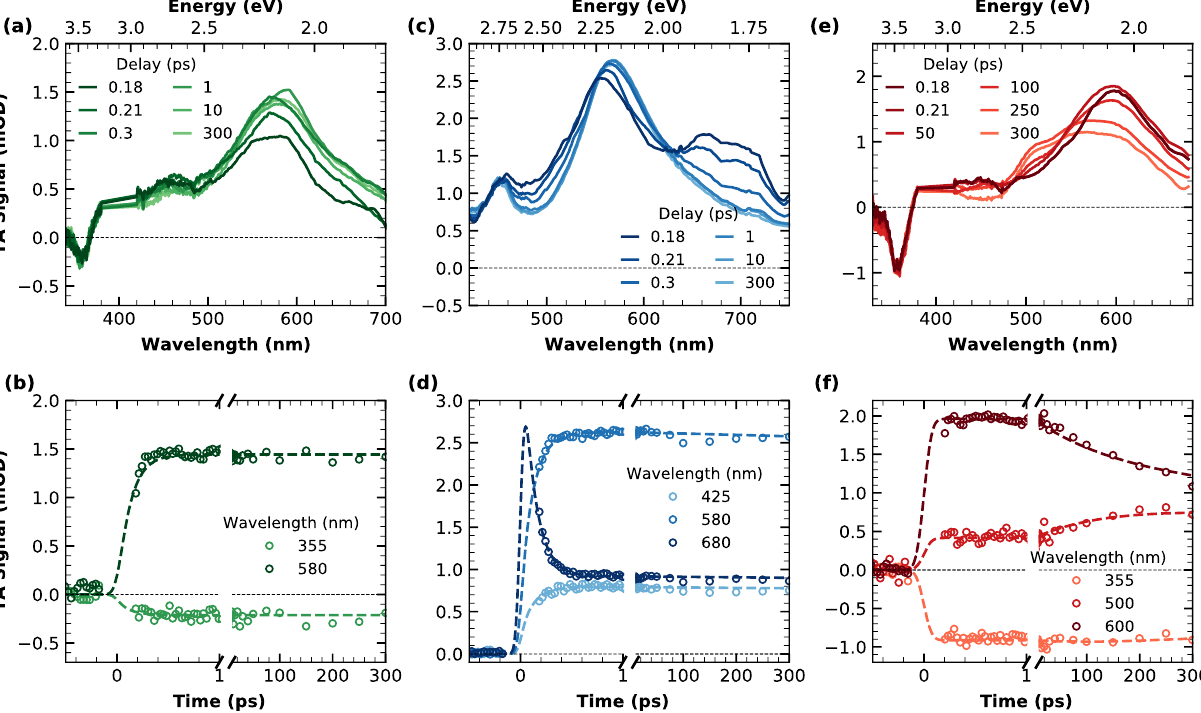
Figure 3. Top panels: transient absorption spectra of ( a ) c-NG , ( c ) m-NG and ( e ) c-Br-NG , acquired at different time delays from photoexcitation ( λ exc = 400 nm). Data around 400 nm were removed because of pump scattering. Bottom panels: transient absorption kinetic traces and relative fitting curves cut at different probe wavelengths of ( b ) c-NG , ( d ) m-NG and ( f ) c-Br-NG .